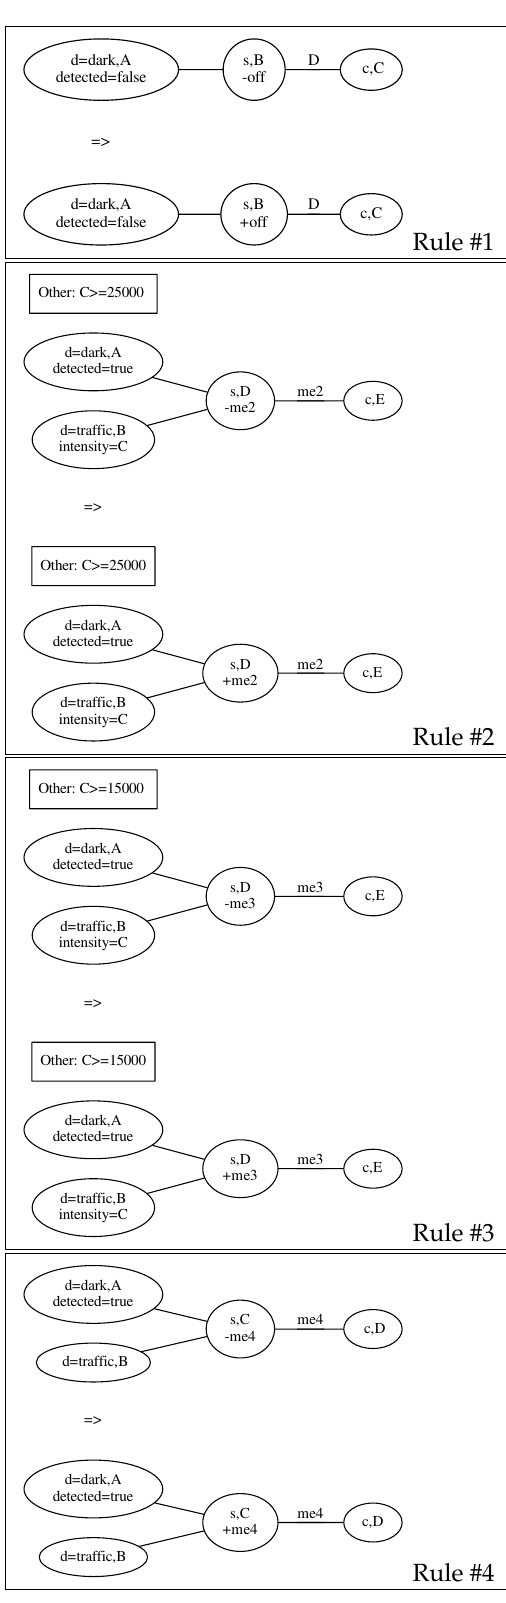
Figure 4. Graph transformations providing